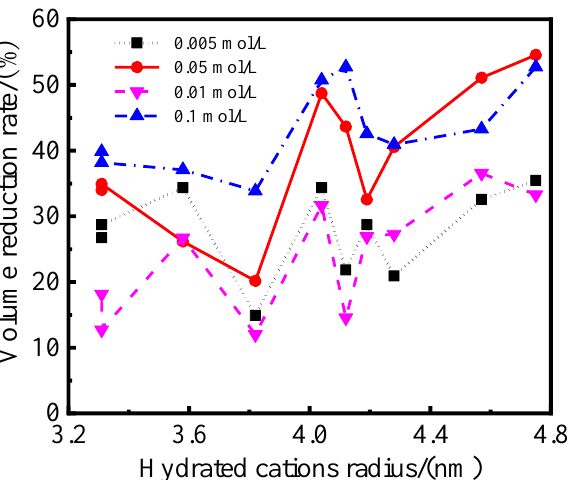
Figure 3. Relationship between hydrated cations radius and volume reduction rate of samples. The relationship between the surface charge density of hydrated cations (the ratio of the quantity of charge to the surface of hydrated cations [34]) and volume reduction rate of modified PS samples was shown in Figure 4. It can be seen that the volume reduction rate of the samples based on different modifiers increased with the increase of the surface charge density of hydrated cations. The surface charge density of cations had a significant effect on the hydration degree between cations and water molecules: the higher the surface charge density of cations were, the thicker the surface hydration film of cations [34]. On the one hand, the surface charge density of cations significantly affects the electrostatic interaction between cations and the surface of the crystal layer of the sample. In other words, the higher the cation surface charge density was, the stronger the electrostatic interaction between the surface of the crystal layer of the sample was when other conditions remained unchanged. In this way, the adsorption of cations on the surface of the crystal layer prevent water molecules from interacting with the surface of the crystal layer, thereby inhibiting its hydration expansion. In addition, the electrostatic interaction of the cations with the surface of the crystal layer of the sample also inhibits the hydration of the cations [35]. In summary, it can be seen that the higher the surface charge density of the cations were, the more obvious the inhibitory effect on the hydration expansion of PS was. This conclusion is similar to that in the literature [36].